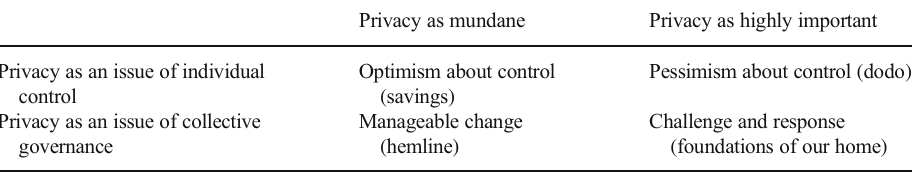
Table 8 Privacy conception and the key issue of the future